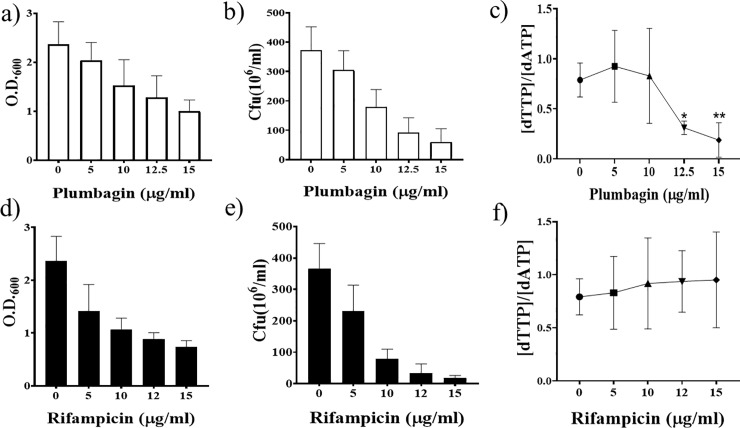
Effect of plumbagin (a-c) and rifampicin (d-f) on cell viability and [dTTP]/[dATP] ratio. Survival after plumbagin and rifampicin treatment at the doses mentioned was measured by either OD600 (a and d) or CFU/ml (b and e). The corresponding [dTTP]/[dATP] ratios derived by performing mass spectrometric analysis are shown in (c) and (f). The experiments were performed five times. The complete dNTP profiles from which these ratios were derived are presented in S2 Fig. The results are presented as mean ± SD (standard deviation). Significant differences in the [dTTP]/[dATP] ratios of the treated samples relative to the untreated ones are marked by asterisks, * for p = 0.0104 and ** for p = 0.0078. Significance levels (p values) were determined by performing paired t-tests using Graph Pad Prism software.